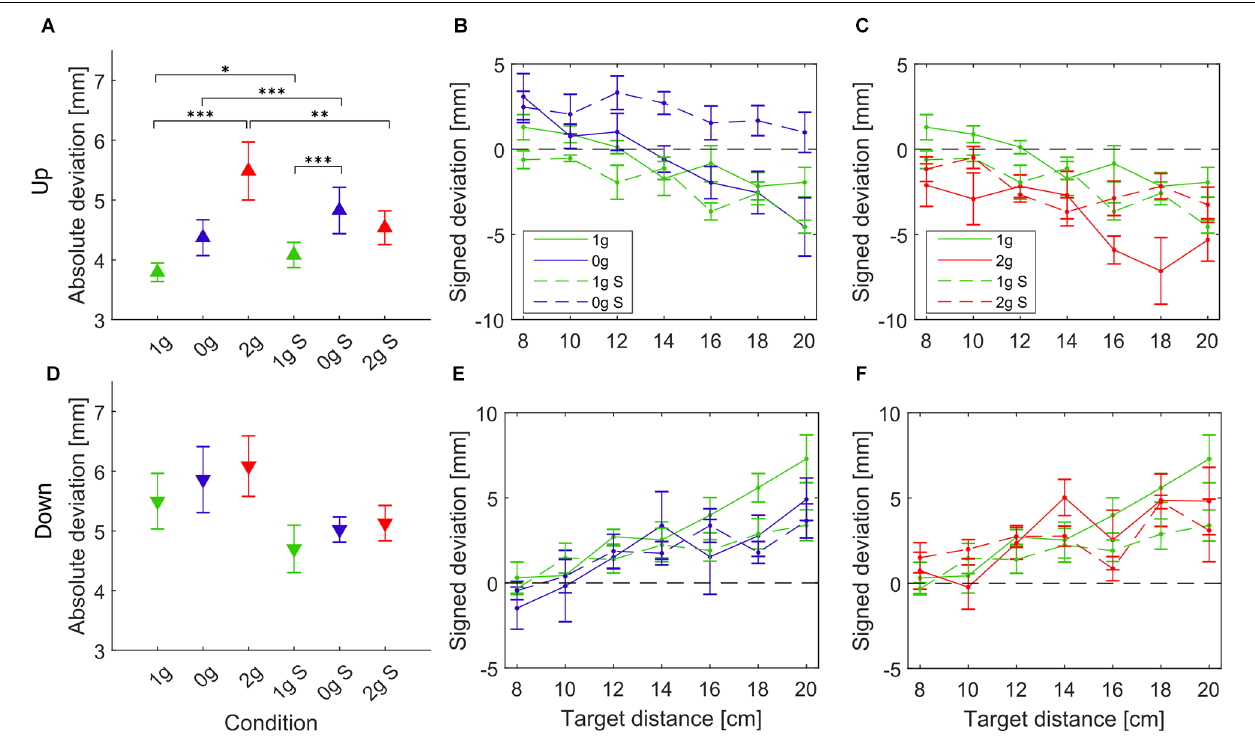
FIGURE 2 | Absolute deviations of the pointing position averaged for all subjects and grouped per condition for upward movements (A) and downward movements (D) . Signed deviations for every target in microgravity (B,E) and hypergravity (C,F) for upward and downward movements, respectively. Downward-pointing triangles denote mean values for downward movements, upward-pointing triangles denote mean values for upward movements, the whiskers denote the standard error of the mean. Green represents normogravity, blue represents microgravity and red represents hypergravity conditions, (1g, 0g, 2g) denote in-flight gravitational conditions, (1g S, 0g S, 2g S) denote simulated gravitational conditions. ∗ p < 0.05, ∗∗ p < 0.01, ∗∗∗ p < 0.001.